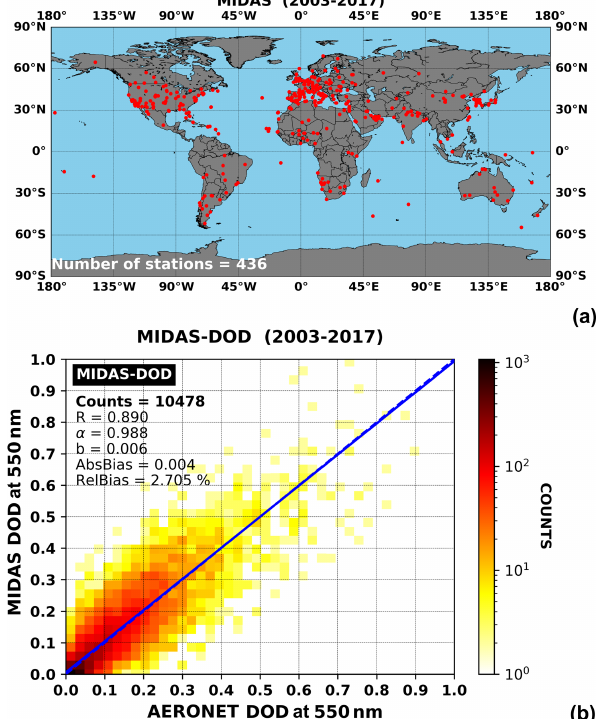
Figure 3. (a) AERONET sites where at least one pair of ground- based and spaceborne retrievals has been recorded according to the defined colocation criteria during the period 2003–2017. (b) Den- sity scatterplot between MIDAS ( y axis) and AERONET ( x axis) dust optical depth at 550nm. The solid and dashed lines stand for the linear regression fit and equal line ( y = x ),